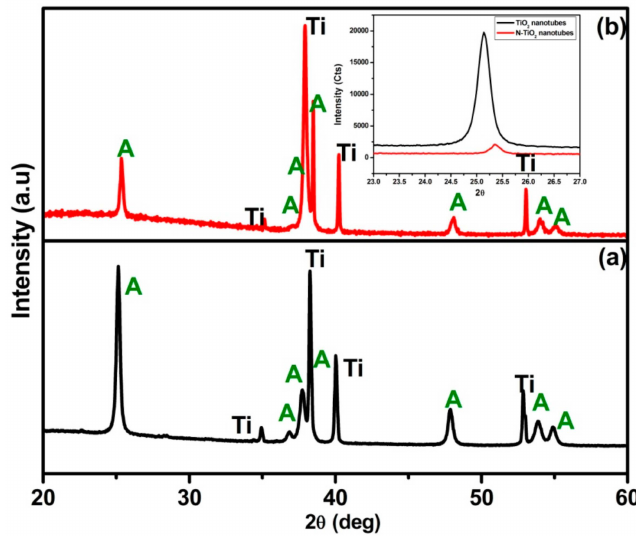
Figure 1. X-ray di ff raction (XRD) pattern of ( a ) TiO 2 nanotubes and ( b ) N-TiO 2 nanotubes. Inset contains magnified view between 23–27 ◦ (2 θ Position).